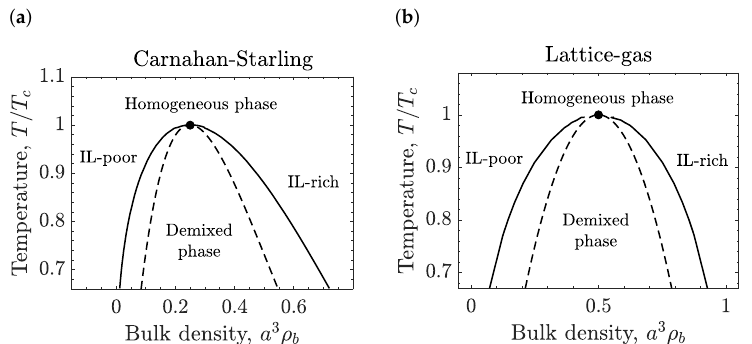
Figure 4. Bulk phase diagrams of ionic liquid (IL)-solvent mixtures. ( a ) Excluded volume given by the Carnahan-Starling approximation. ( b ) Excluded volume given by the lattice-gas approximation. The solid lines represent the first order phase transition between the homogeneous and IL-solvent demixed phases, and the dashed lines are the spinodal curves. The circles denote (upper) critical points. Temperature is expressed in terms of the critical temperature T c